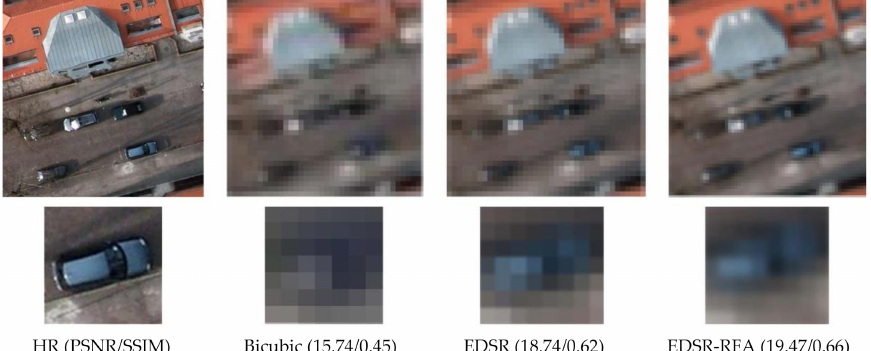
Figure 4. Comparing SR images generated by EDSR and EDSR-RFA: HR image at the top left has a ground resolution of 5 cm/pixel while the LR version was generated using a scale factor of 16, which corresponds to a ground resolution of 80 cm/pixel, image super-resolution at 5 cm/pixel using bicubic interpolation, EDSR, and EDSR-RFA. Top: full image 512 × 512 pixels, Bottom: the zoomed image of 100 × 100 pixels showing a black